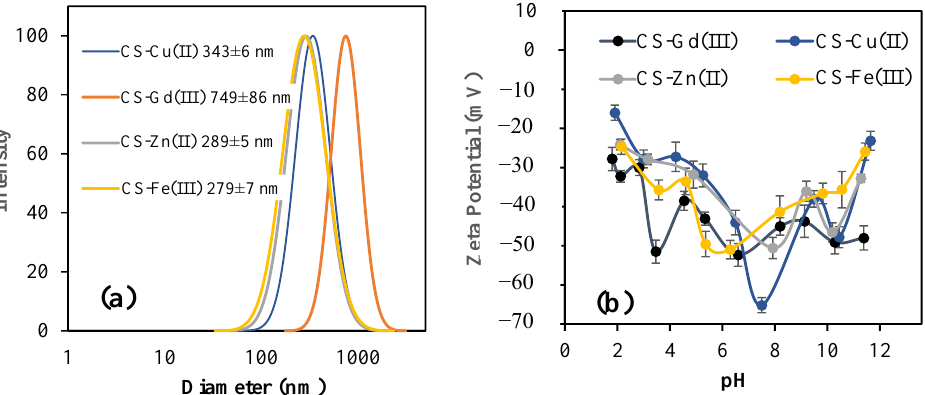
Figure 2. ( a ) Size distribution of CS-Fe(III), CS-Gd(III), CS-Zn(II), and CS-Cu(II) particles using DLS measurements, and ( b ) their zeta potential values at pH range from 2 to 10.